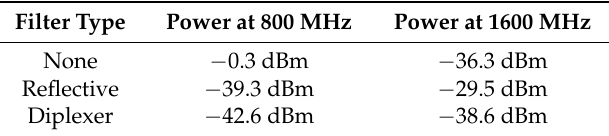
Table 1. Filter testing results to improve dynamic range.